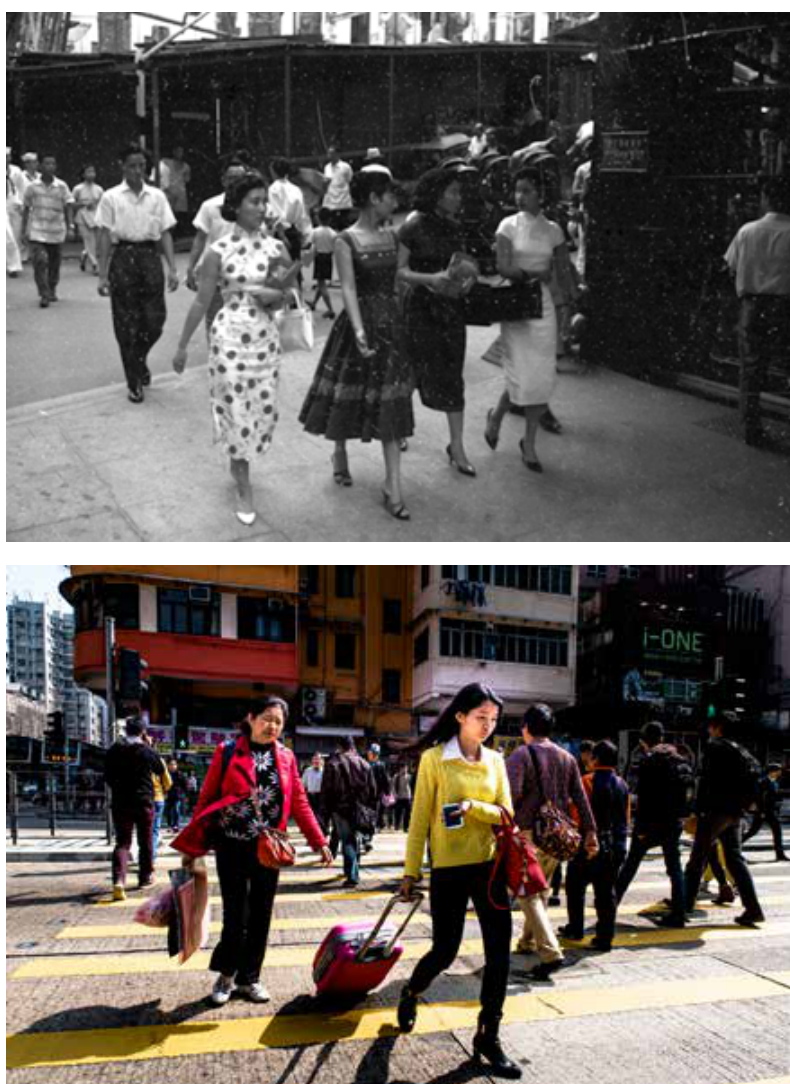
Figure 8b (opposite, middle left): Phil Shek, Hanging out after School, Lai Chi Kok Station, Kowloon, 2014. Figure 9a (opposite, middle right): Nick Howard, Rickshaw Man, Tsim Sha Tsui Bus Station, Kowloon, 1957/58. Figure 9b (opposite, bottom): Phil Shek, Recycle Woman, Wan Chai, Hong Kong Island, 2013. Figure 10a: Nick Howard, Fashionable Ladies, 1957/58. Figure 10b: Phil Shek, Shopping Ladies, Shun Shui Po, Kowloon,